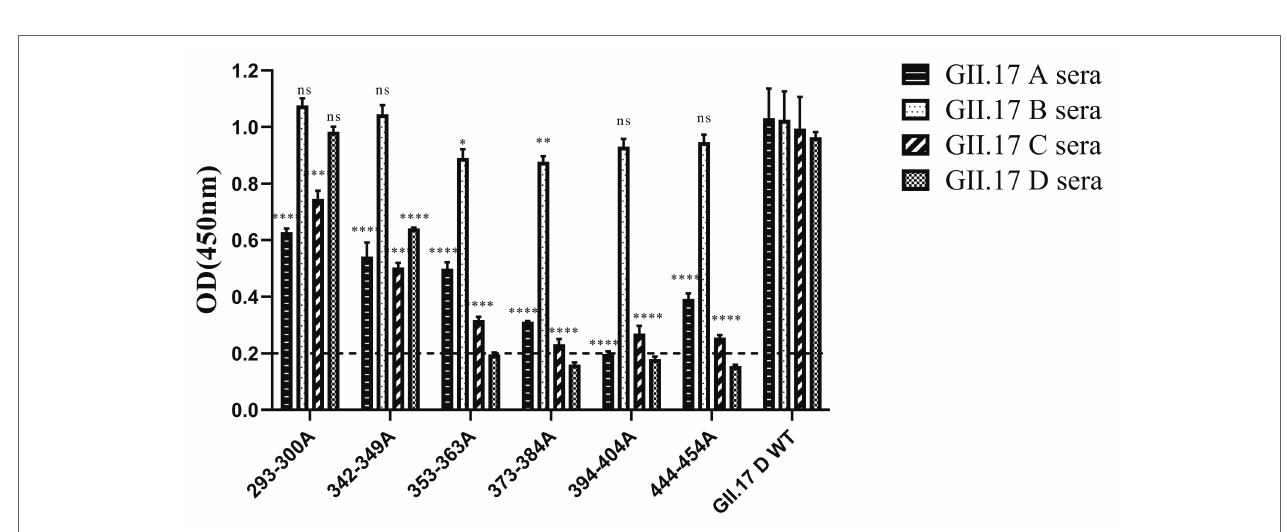
FIGURE 5 | Cross-reactivity of six NoV GII.17 D mutants with GII.17 (A–D) antisera. OD values were expressed as the mean ± SD. Horizontal line illustrates the cut-off value for samples considered positive. * Significantly different from wild-type GII.17 D variant sera (by analysis of variance). * p < 0.05; ** p < 0.01; *** p < 0.001; and **** p < 0.0001. ns, not